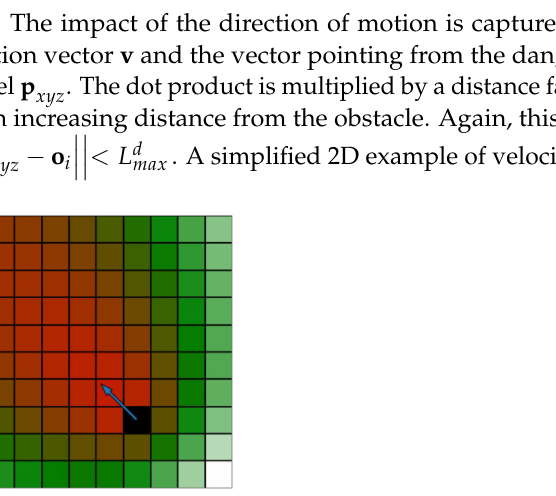
Figure 3. Simplified 2D visualization of velocity classification of voxels around an obstacle (the black voxel); the arrow represents the movement vector of the